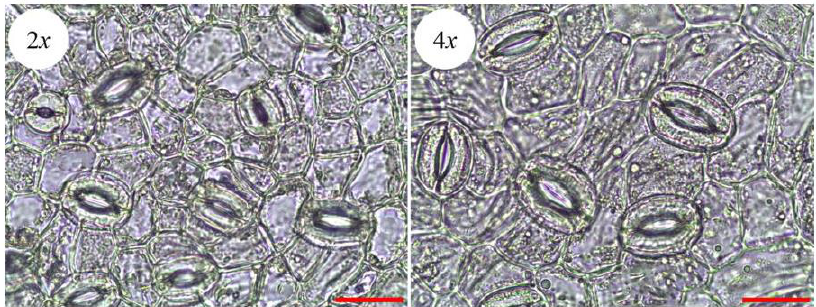
Figure 6. Stoma morphological of ‘Xingtai 0604′ (2 x ) and ‘Zhuguang’ (4 x ). Both bars represent 25 μm.